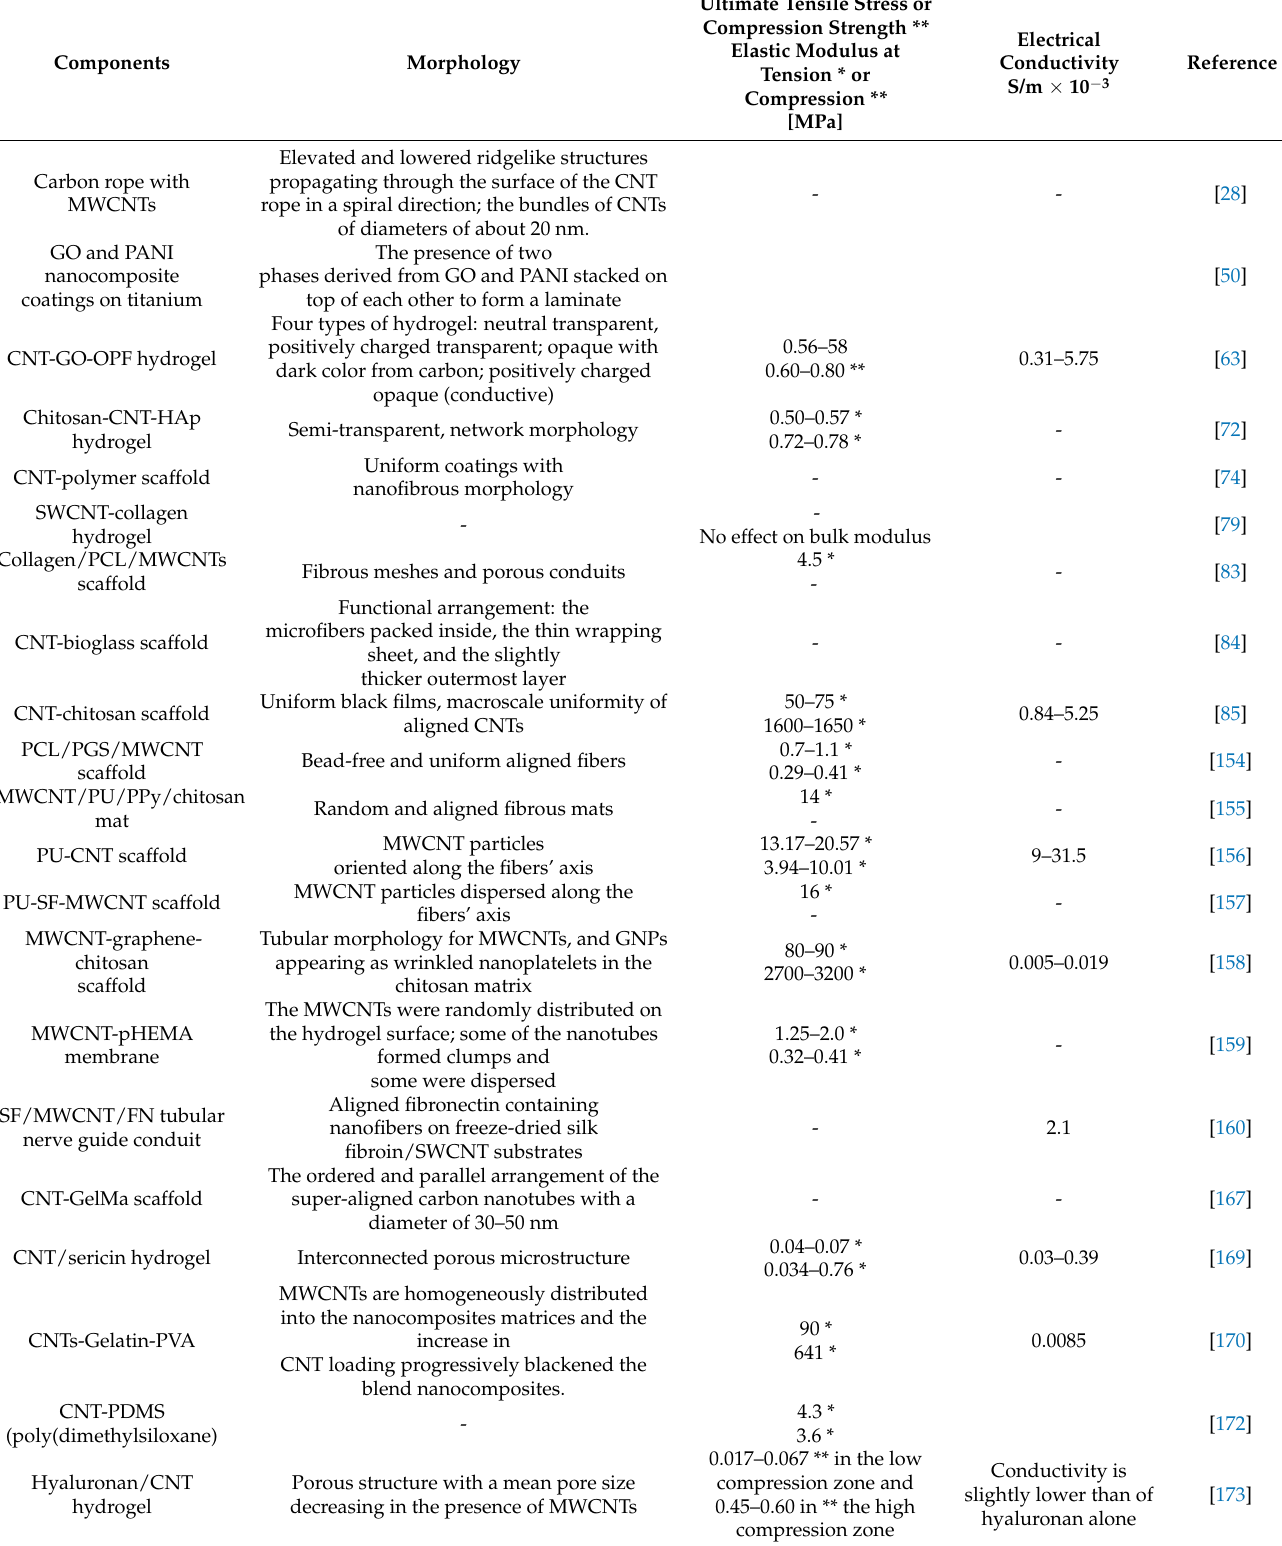
Table 1. Mechanical and electrical properties of CNT-implemented coatings and